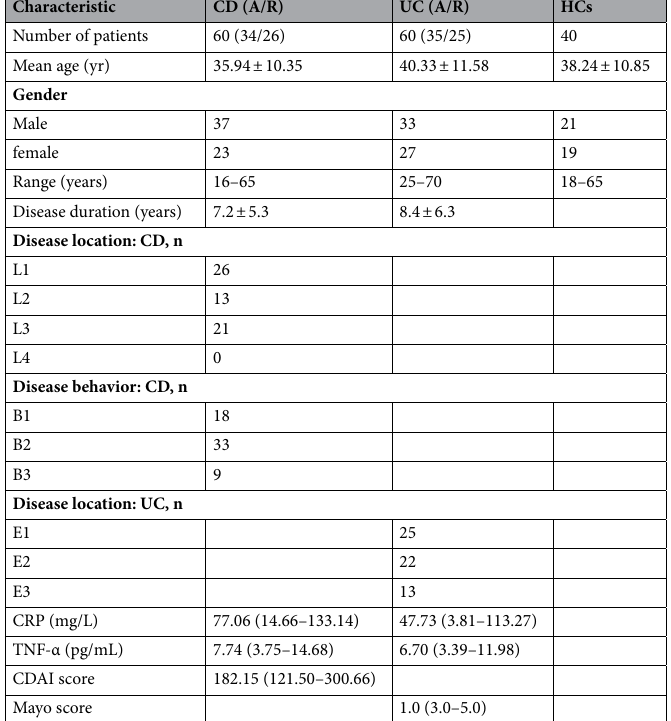
Table 1. Clinical characteristics of IBD patients and controls. The data are presented as the mean ± SD or medians (1/4–3/4 quarters). Patients with isolated upper disease (L4) were excluded. L1 terminal ileum, L2 colon, L3 ileocolon, B1 non-stricture and non-penetrating, B2 stricturing, B3 penetrating, E1 rectum, E2 left side, E3 extensive, CD Crohn’s disease, UC ulcerative colitis, HCs healthy controls, CRP C-reactive